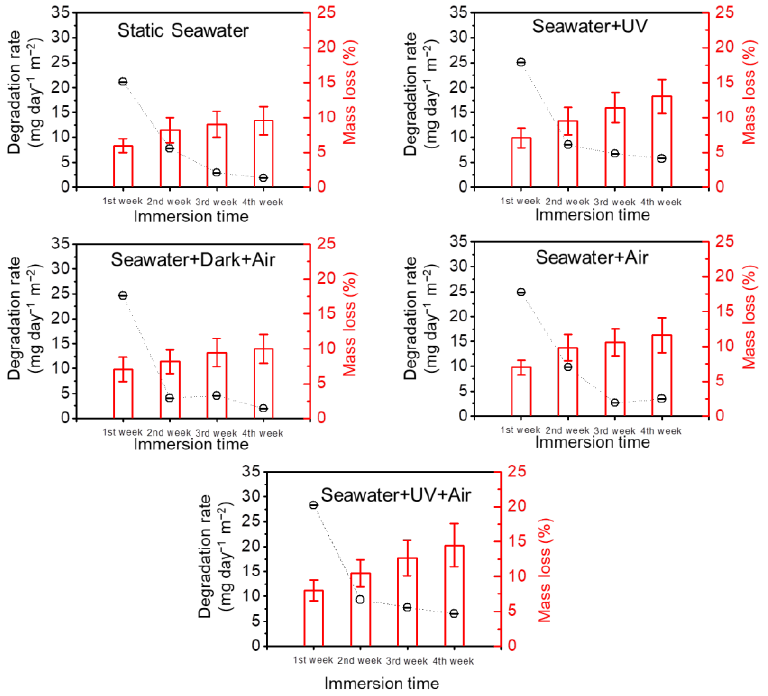
Figure 3. Degradation rate and mass loss as a function of immersion time with various immersion methods.